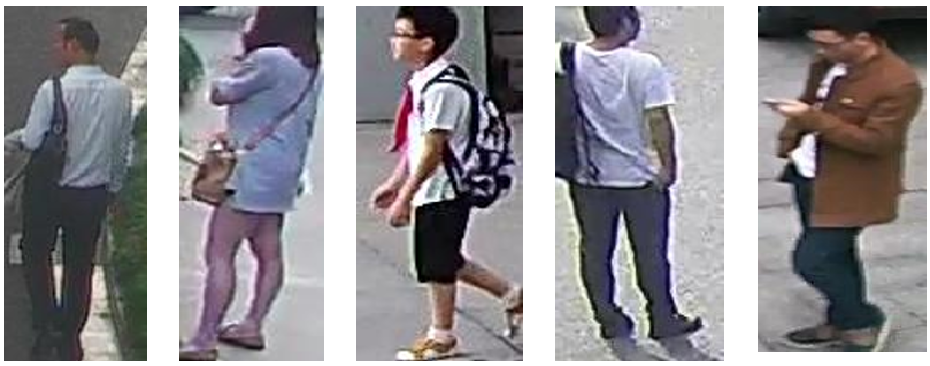
Figure 8. Sample images of PARSE100K